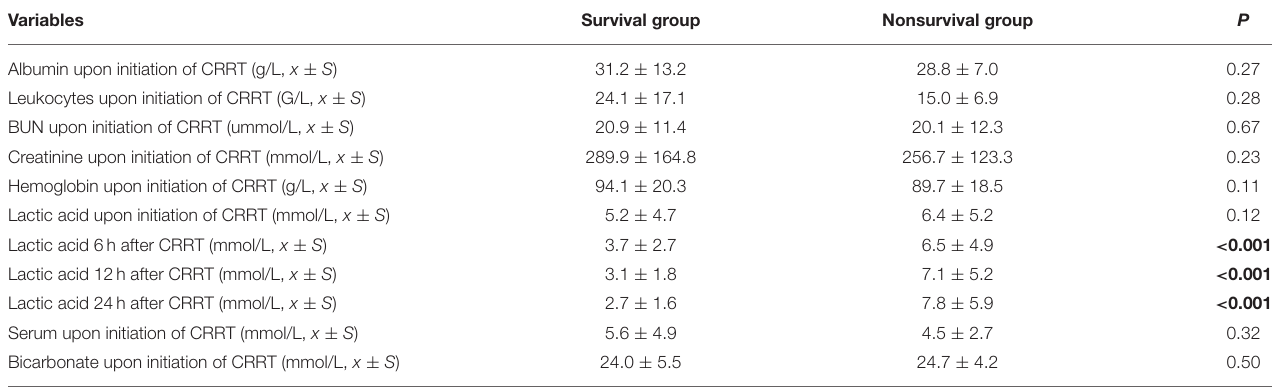
TABLE 3 | Laboratory indicators during CRRT in the survival and nonsurvival groups. Variables Survival group